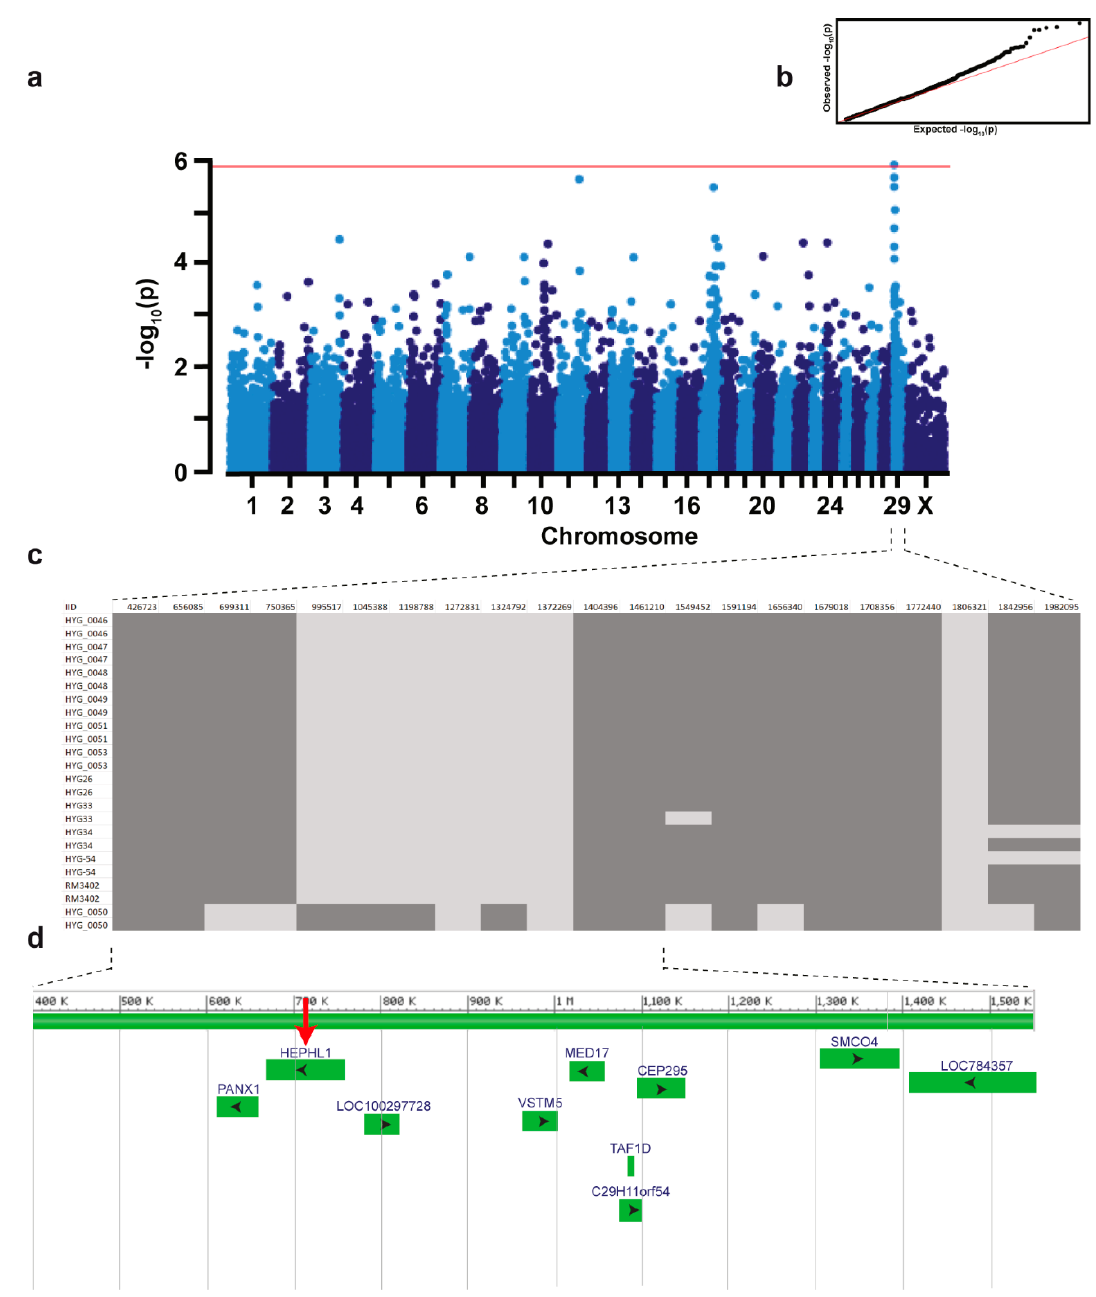
Figure 2. A region on chromosome 29, including the HEPHL1 gene, is associated with recessive congenital hypotrichosis in Belted Galloway cattle. ( a ) Manhattan plot for the GWAS using 12 HY-suspected calves and 61 control cattle is shown and indicates a signal with multiple associated SNPs on chromosome 29. Each chromosome is represented along the X-axis. The Y-axis represents the − log 10 of the corrected empirical p -value. The red line indicates the Bonferroni-corrected significance with a − log 10 p = 5.88 ( α = 0.05). ( b ) The quantile-quantile plots showing the observed vs. expected log p -values are shown. ( c ) Schematic representing the haplotypes of 12 HY-suspected calves on chromosome 29. The exact positions of the SNP markers are indicated above. ( d ) Gene content of the 1.5 Mb-sized critical regions located at the proximal end of the chromosome. Screenshot of NCBI Genome Data Viewer (ARS-UCD1.2 assembly, Bos taurus annotation release 106) shows the annotated genes and loci including HEPHL1 (red arrow).